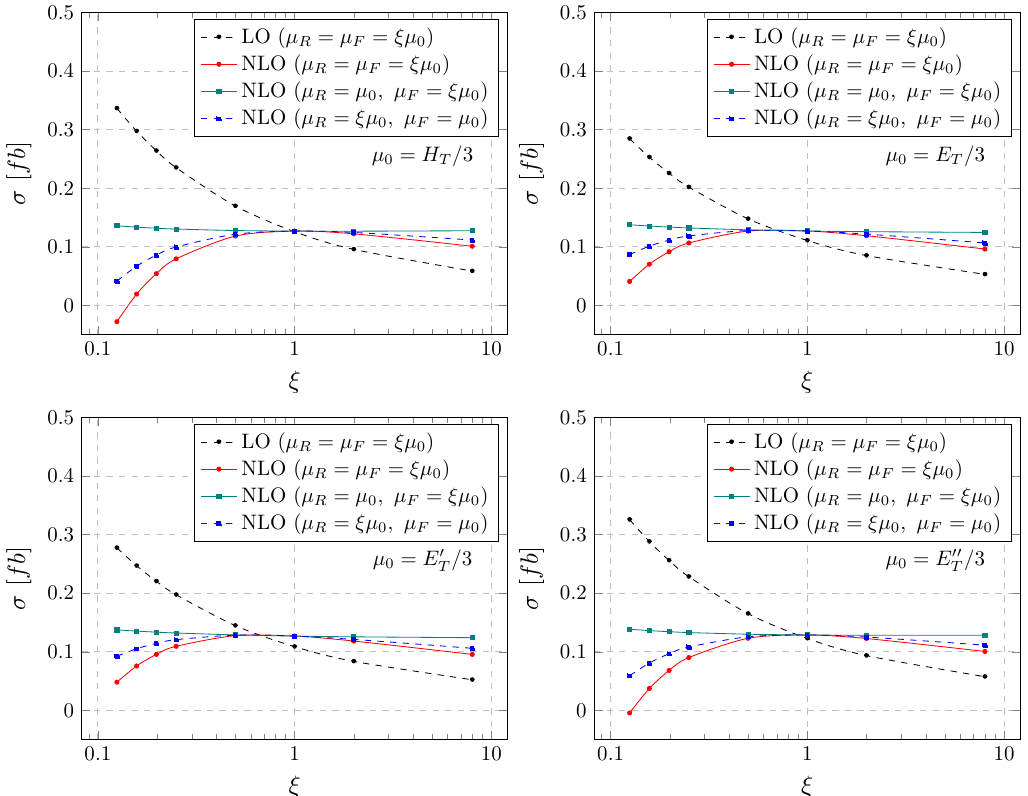
Figure 4 . Scale dependence of the LO and NLO integrated cross section for the pp e + (cid:23) e (cid:22) (cid:0) (cid:22) (cid:23) (cid:22) b (cid:22) b (cid:23) (cid:28) (cid:22) (cid:23) (cid:28) + X process at the LHC run II with p s = 13 TeV. Renormalisation and factorisa- tion scales are set to (cid:22) R = (cid:22) F = (cid:24)(cid:22) 0 where (cid:22) 0 = H T = 3 ; E T = 3 ; E 0 The LO and NLO CT14 PDF sets are employed. For each case of (cid:22) 0 also shown is the variation of (cid:22) R with (cid:12)xed (cid:22) F and the variation of (cid:22) F with (cid:12)xed (cid:22) R .